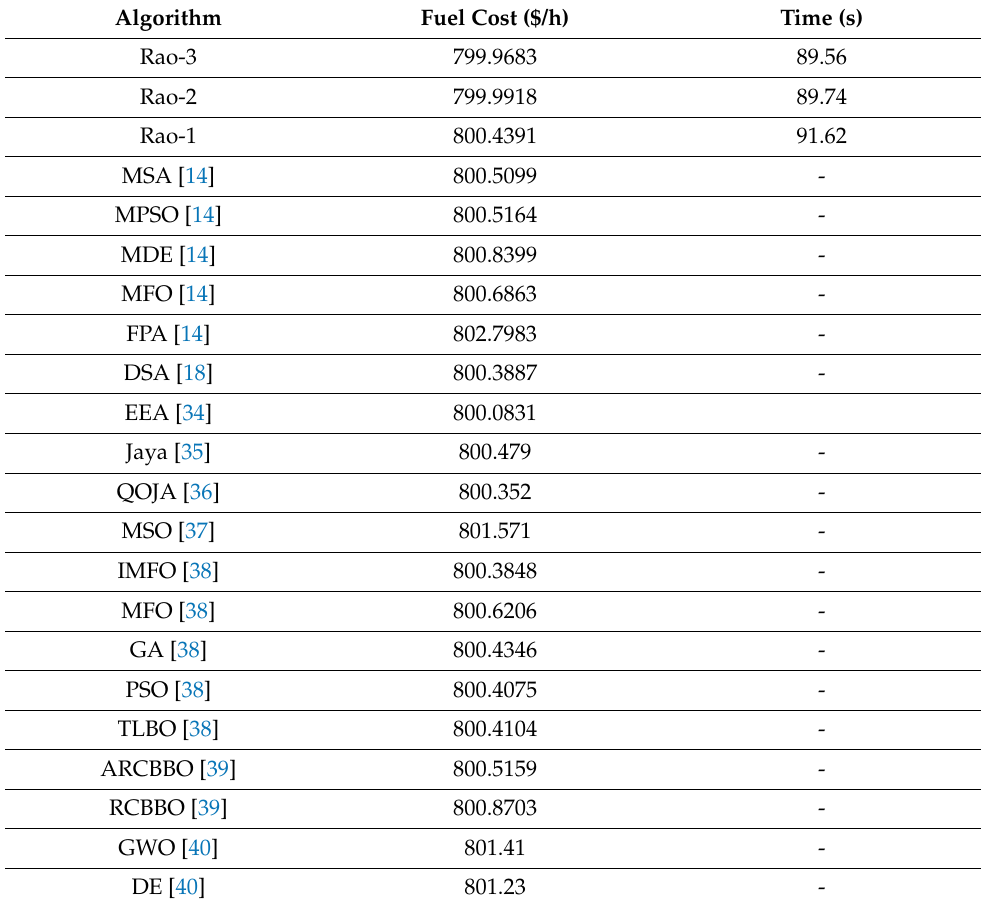
Table 2. Case 1: FCM in the IEEE 30-bus